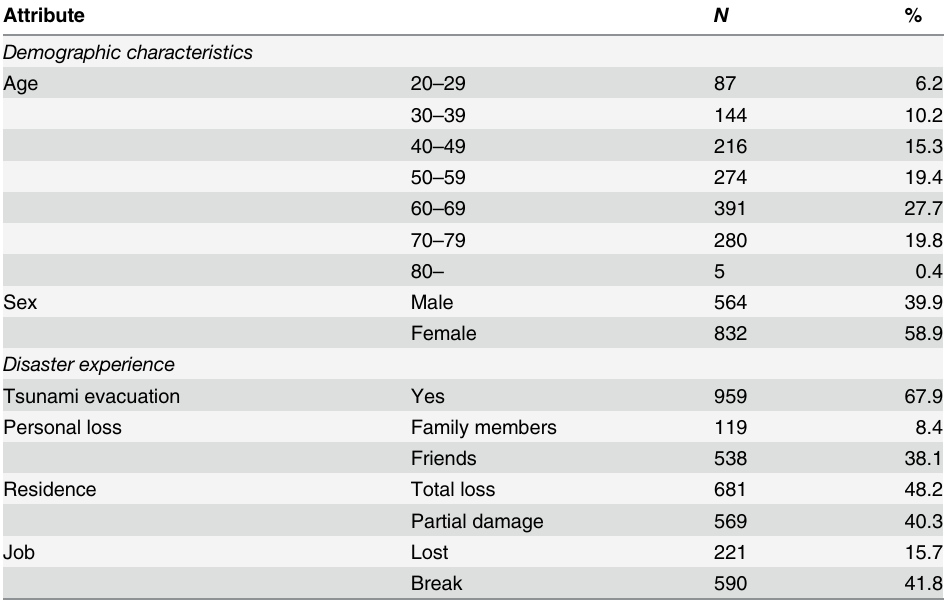
Table 1. Demographic profiles and disaster experiences of